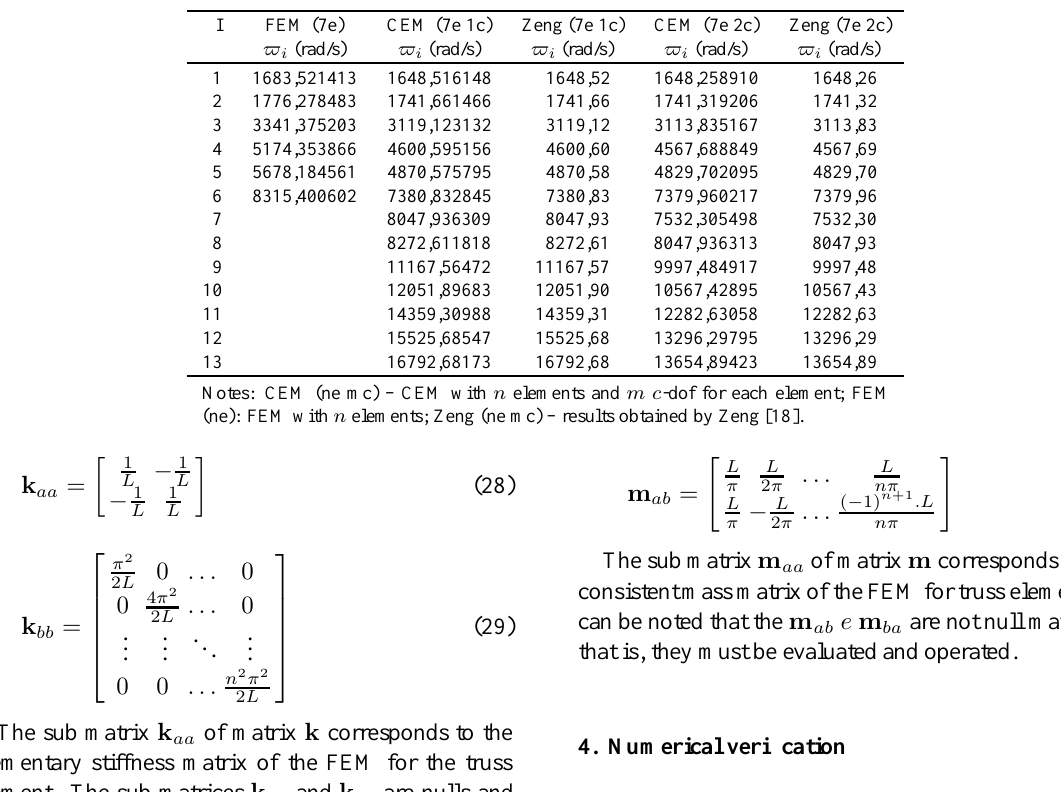
Table 2 Results obtained through the FEM and the CEM for the plane